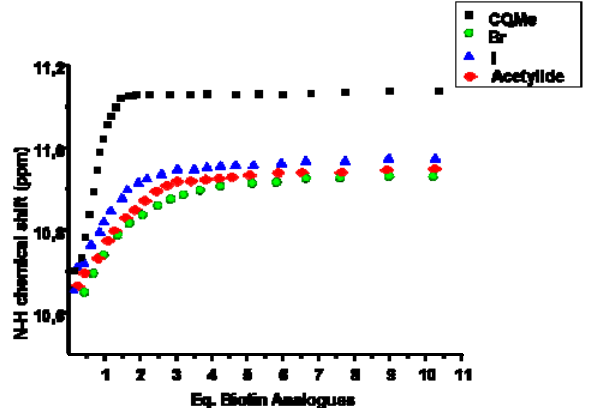
Figure 4. Variations on the chemical shifts of the N- H group in host III as function of the equivalents of added guest in ST